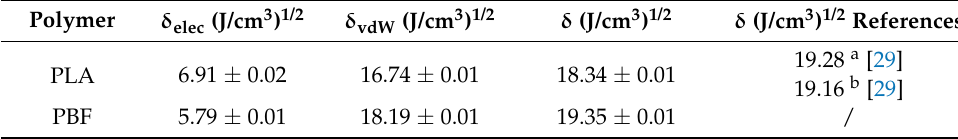
Table 2. Solubility parameters of PLA and